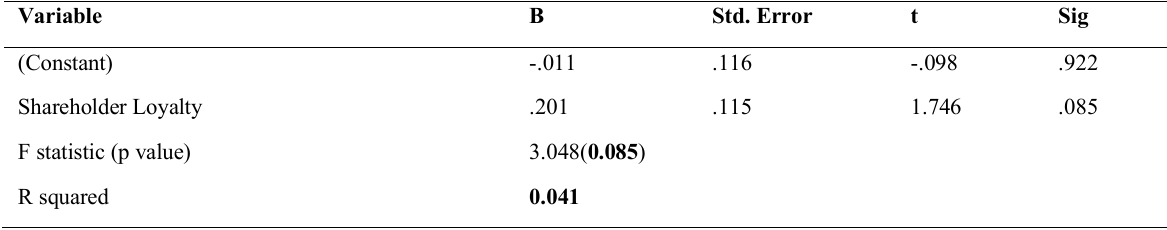
Table 5: Regression analysis for